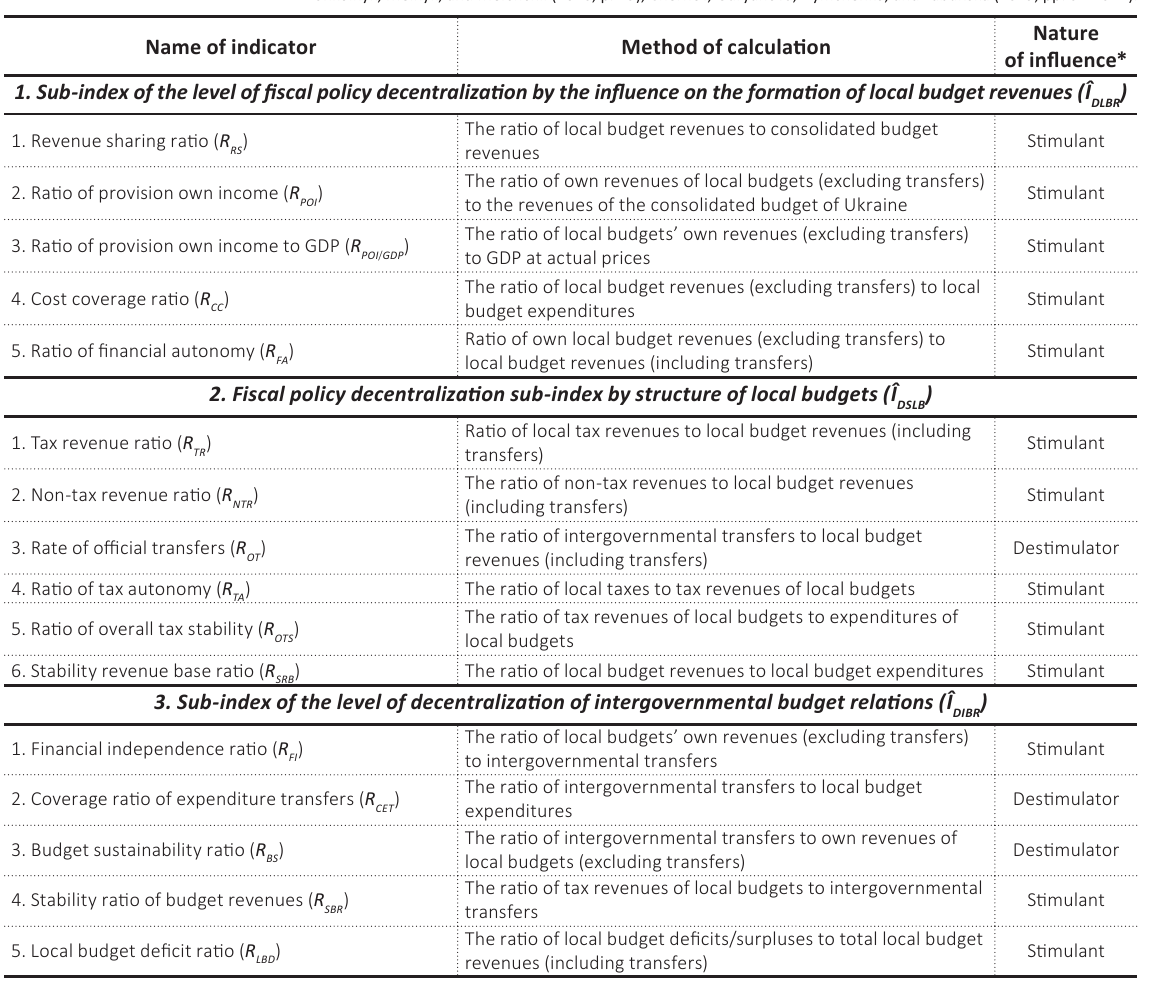
Table 1. Identification and grouping of fiscal policy decentralization